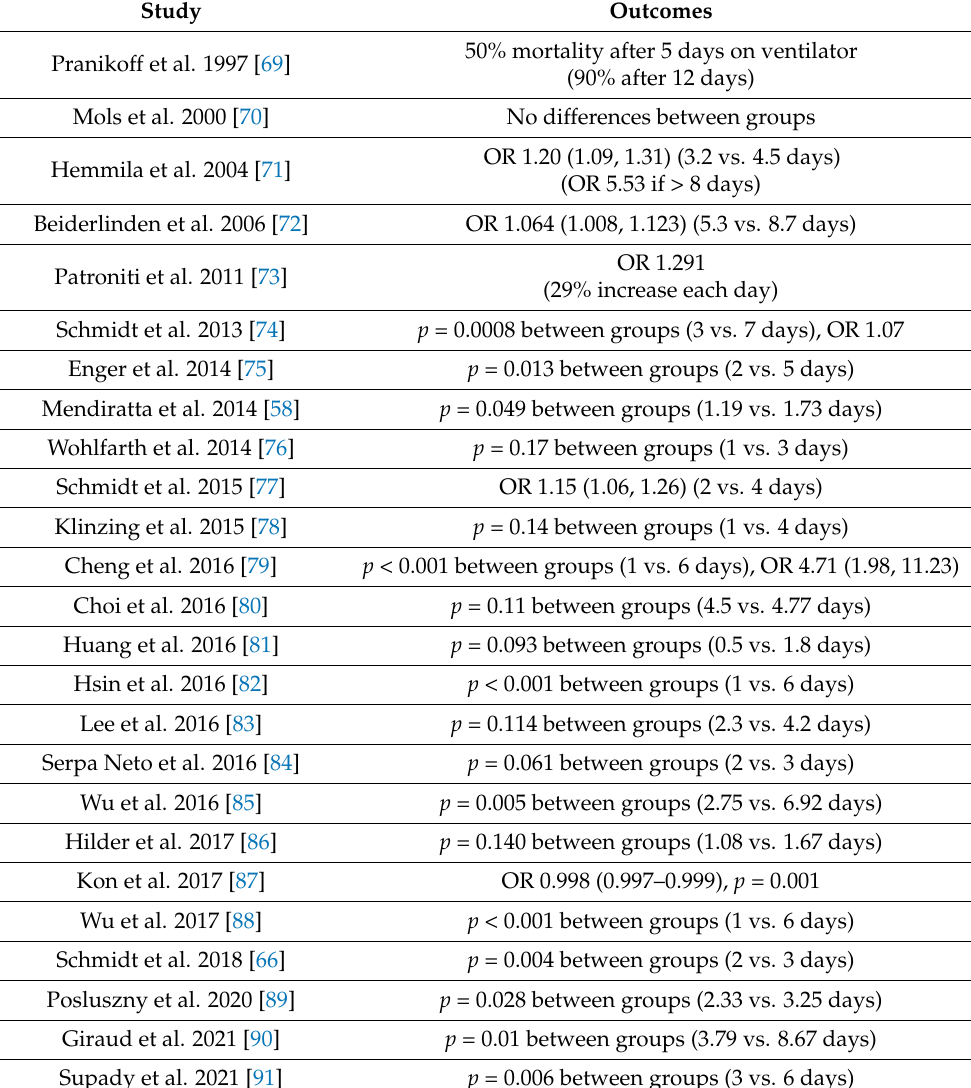
Table 5. Evidence for the relevance of time on ventilator prior to ECMO and the respective